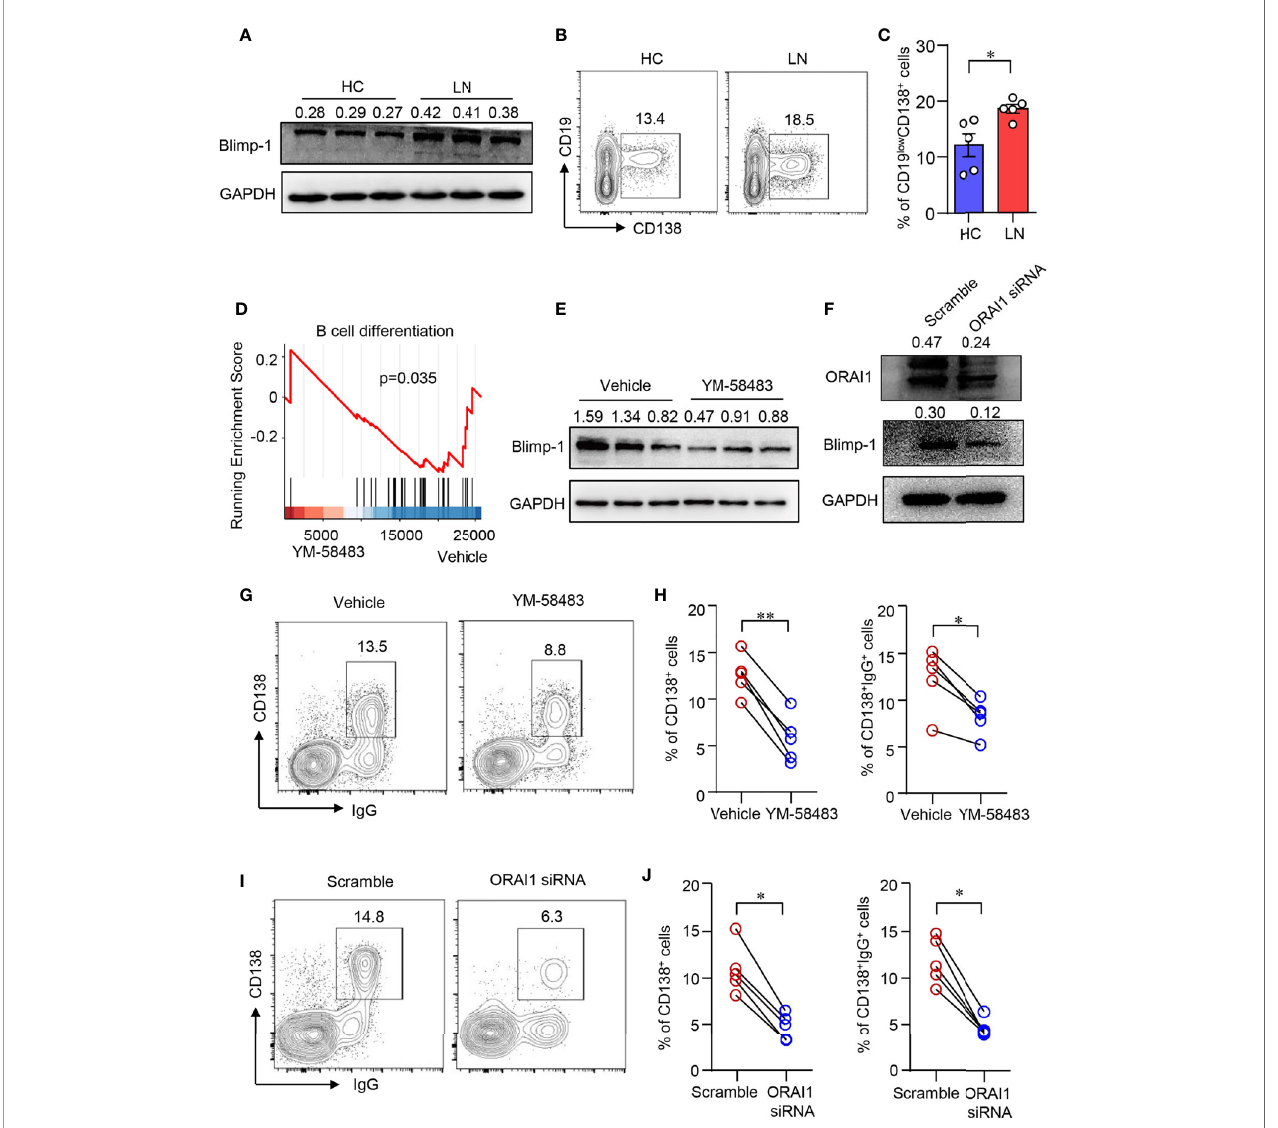
FIGURE 3 | CRAC channel inhibition suppressed B cell differentiation. (A) Blimp-1 expression in B cells from patients with lupus nephritis (LN) or healthy controls (HC) was measured by Western blot and representative bands of six independent samples. (B, C) Naive B cells from LN or HC were cultured in the presence of anti- IgM (5 m g/ml), anti-CD40 (1 m g/ml), IL-2 (20 ng/ml), IL-4 (20 ng/ml), and IL-21 (50 ng/ml) for 8 days. Percentages of CD19 low CD138 + plasma cells were determined by fl ow cytometry. Representative counter plots are shown and data from fi ve samples. Data are mean ± SEM. *p < 0.05 by t-test. (D) GSEA plot for the gene set of B-cell differentiation showing the enrichment scores for YM-58483 or vehicle-treated B cells (n = 3). (E) Blimp-1 expression in B cells treated with YM58483 or vehicle was measured by Western blot and representative bands of six independent samples. (F) Blimp-1, ORAI1 expression in B cells treated with ORAI1 siRNA or scramble siRNA was measured by Western blot. Representative bands of six samples are shown. (G, H) CD138 and IgG expression in B cells treated with YM- 58483 or vehicle. Representative counter plots are shown, and the percentages of CD138 + or CD138 + IgG + cells are summarized in dot plot with bar plot (n = 5). (I, J) CD138 and IgG expression in B cells treated with ORAI1 siRNA or scramble siRNA. Representative counter plots are shown, and the percentage of CD138 + or CD138 + IgG + cells are summarized in dot plot with bar plot (n = 5). For the Western blot data, relative expression values to GAPDH are indicated above each lane. *p < 0.05, **p < 0.01 by paired